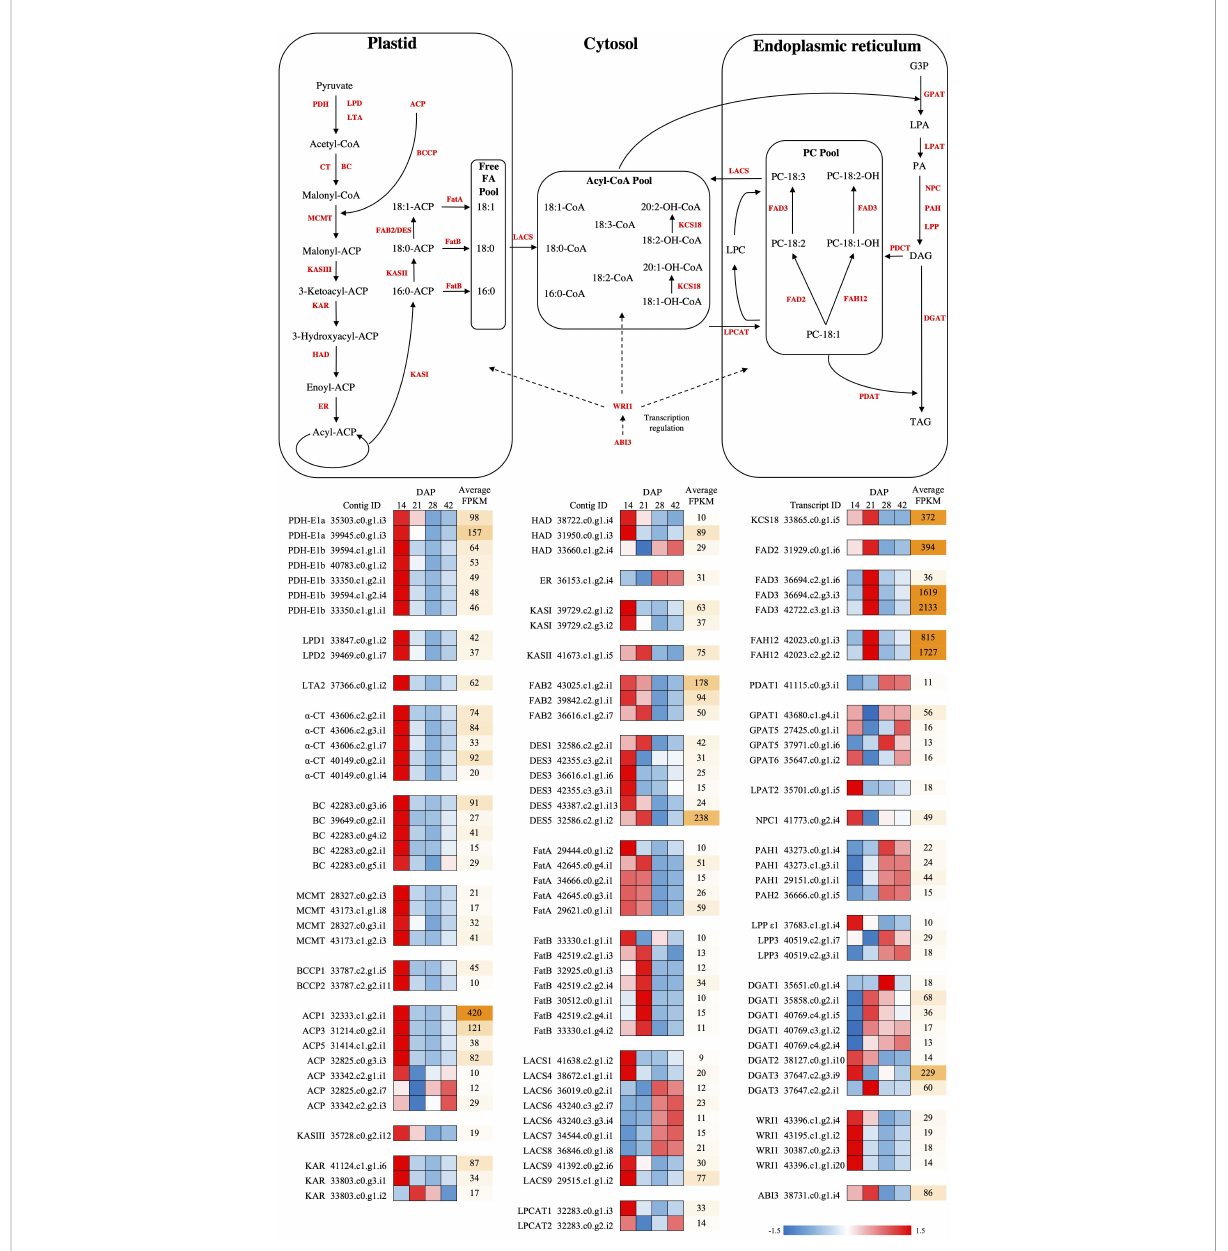
FIGURE 4 Fatty acid synthesis pathways with differential expression during seed development in P. auriculata. The differential expressed genes are presented with mini heatmaps that exhibit their normalized transcript abundance at four stages (from left to right: 14, 21, 28, and 42 DAP), the genes without differential expression are indicated as gray fonts. The dashed lines indicated the transcription regulation in FA/HFA biosynthesis. ACP, acyl carrier protein; BC, biotin carboxylase subunit of acetyl-CoA carboxylase; BCCP, biotin carboxyl carrier protein subunit of acetyl-CoA carboxylase; CT, carboxyltransferase subunit of acetyl-CoA carboxylase; DGAT, diacylglycerol acyltransferase; ER, enoyl-ACP reductase; FAB2/ SAD, stearoyl-ACP desaturase; FatA, acyl-ACP thioesterase A; FatB, acyl-ACP thioesterase B; FAD2, D 12 oleic acid desaturase; FAD3, D 15 linoleic acid desaturase; FAH12, D 12 oleic acid hydroxylase; GPAT, glycerol-3-phosphate acyltransferase; HAD, hydroxyacyl-ACP dehydrase; KAR, ketoacyl-ACP reductase; KASI, ketoacyl-ACP synthase I; KASII, ketoacyl-ACP synthase II; KASIII, ketoacyl-ACP synthase III; KCS18, 3-ketoacyl- CoA synthase 18; LACS, long-chain acyl-CoA synthetase; LPD, dihydrolipoamide dehydrogenase; LPAT, lysophosphatidic acid acyltransferase; LTA, dihydrolipoamide acetyltransferase; MCMT, malonly-CoA ACP malonyltransferase; PDAT, phospholipid diacylglycerol acyltransferase; PDCT, phosphatidylcholine diacylglycerol cholinephosphotransferase; PDH, pyruvate dehydrogenase; PPase, phosphatidate phosphatases; ABI3, ABSCISIC ACID INSENSITIVE 3; LEC1, LEAFY COTYLEDON 1; WRI1, WRINKLED 1; G3P, glycerol-3-phosphate; LPA, lysophosphatidic acid; PA, phosphatidic acid; DAG, diacylglycerol; TAG, triacylglycerol; LPC, lysophosphatidylcholine; PC,